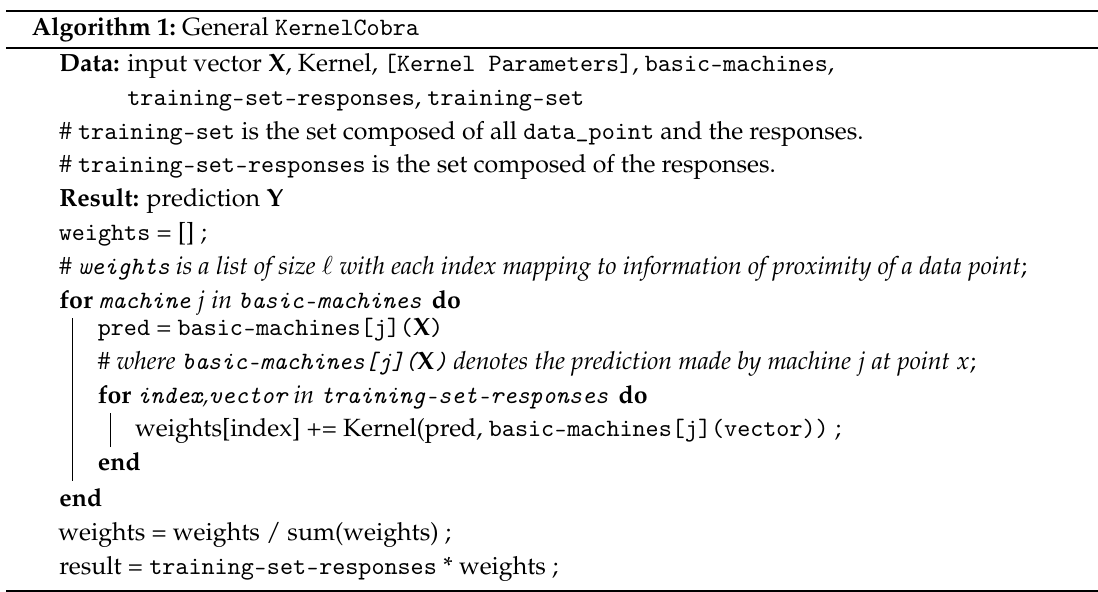
Algorithm 1: General